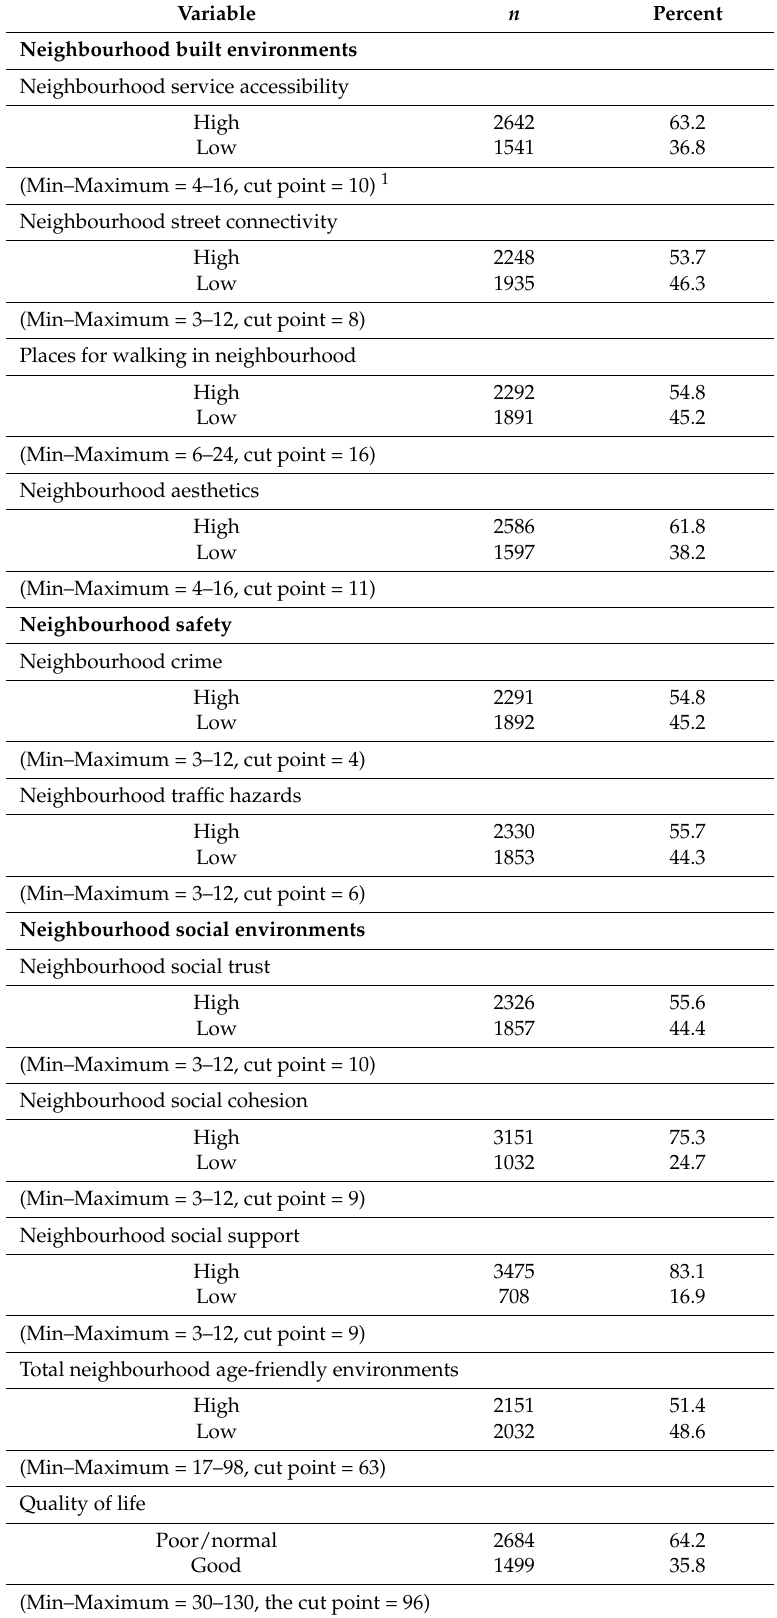
Table 2. Descriptive statistics of age-friendly environments and quality of